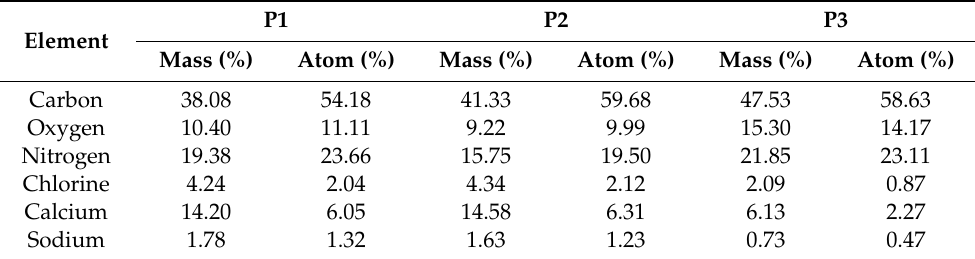
Table 2. Mass and atomic compositions for the P1, P2 and P3 electrospun samples.